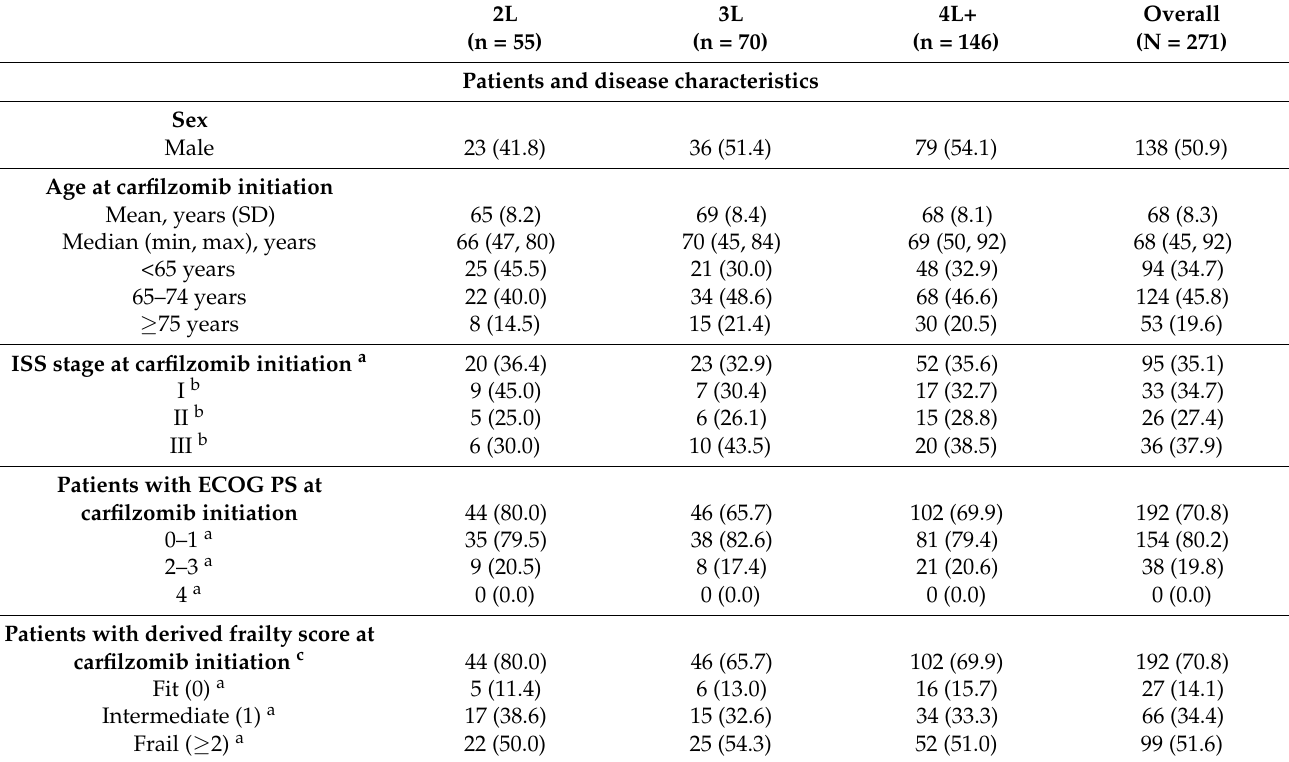
Table 1. Baseline disease and patient characteristics and treatment history for study patients, overall and by line of